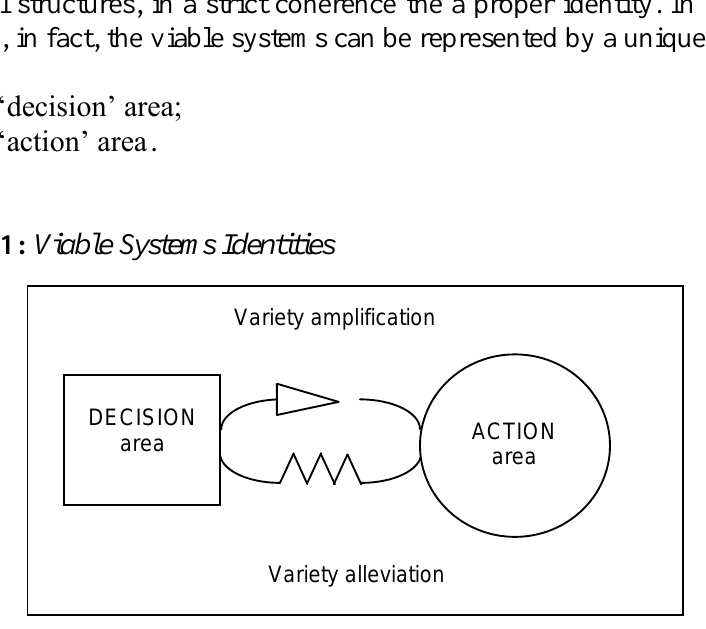
Source: S.Beer, ‘Analysis and organizational projecting’